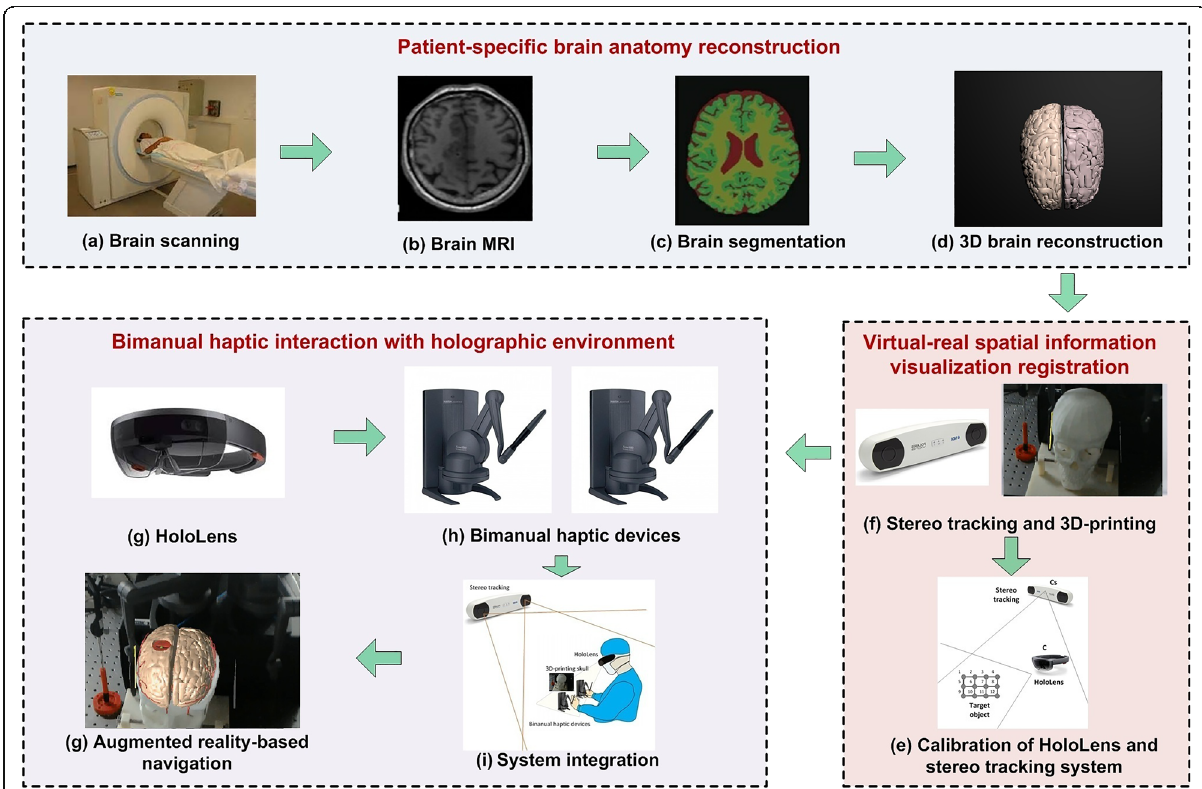
Fig. 1 Overview of augmented reality guidance for neurosurgery